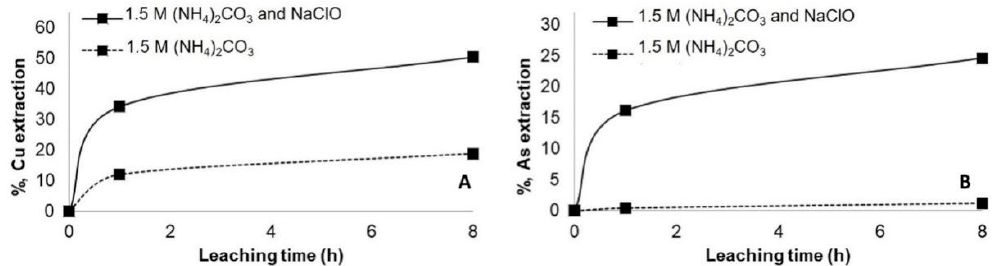
Figure 8. Copper ( A ) and arsenic ( B ) extraction at ambient condition using 1.5 M of (NH 4 ) 2 CO 3 with and without the addition of 10 g/L NaClO.